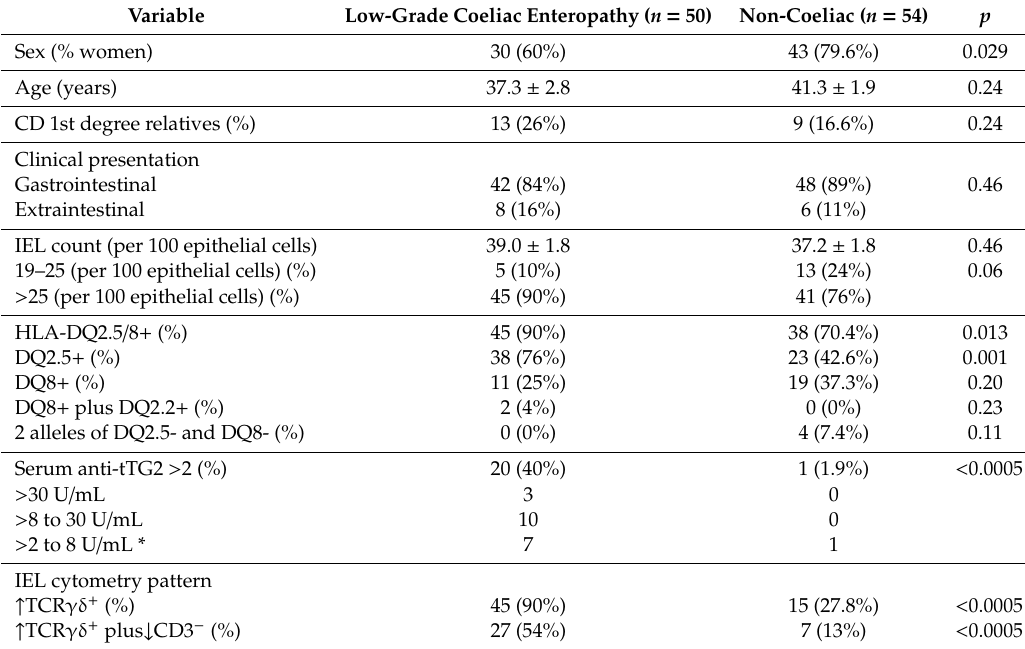
Table 1. The clinical and biological characteristics of the included patients according to the final diagnosis.